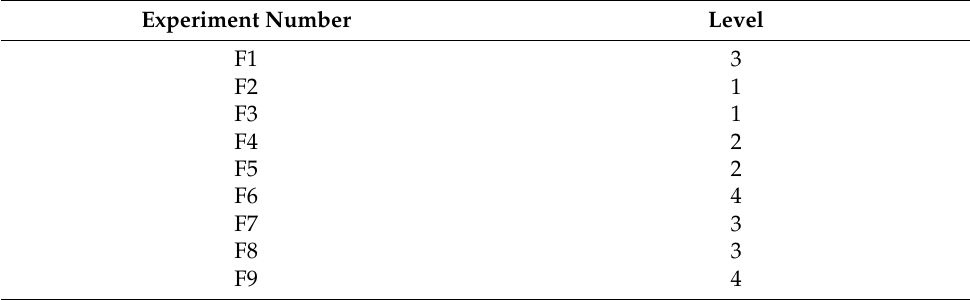
Table 2. Test results of the adhesion of the pure and functional PU films.